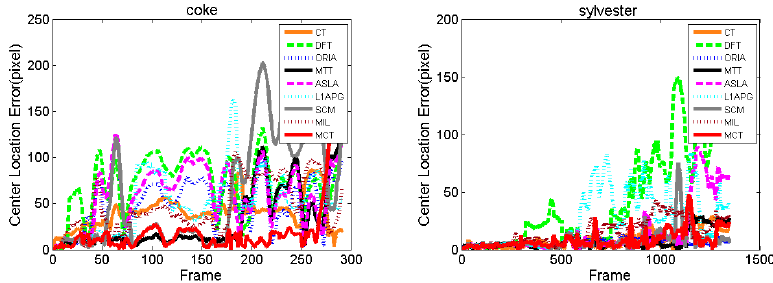
Figure 6. Center location error comparison of the algorithms.